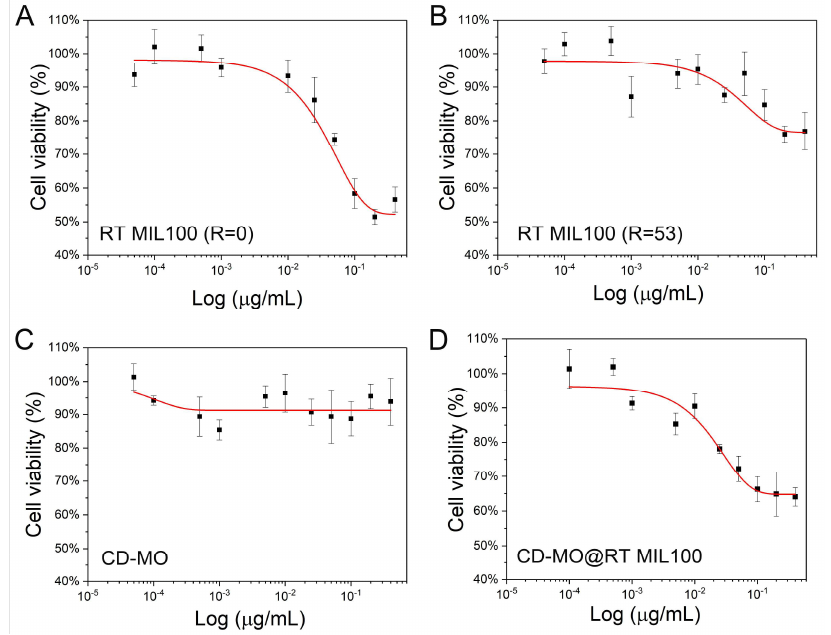
Figure 7. Macrophage J744 cells dose-response curves after treatment with nanoparticles (MTT assay). Cell viability was tested after treatment with ( A ) RT MIL100 (R = 0); ( B ) RT MIL100 (R = 53); ( C ) CD-MO; ( D ) CD-MO@RT MIL100. Results were exploited as mean ± SD for IC50 values obtained from three or four repeats for each individual